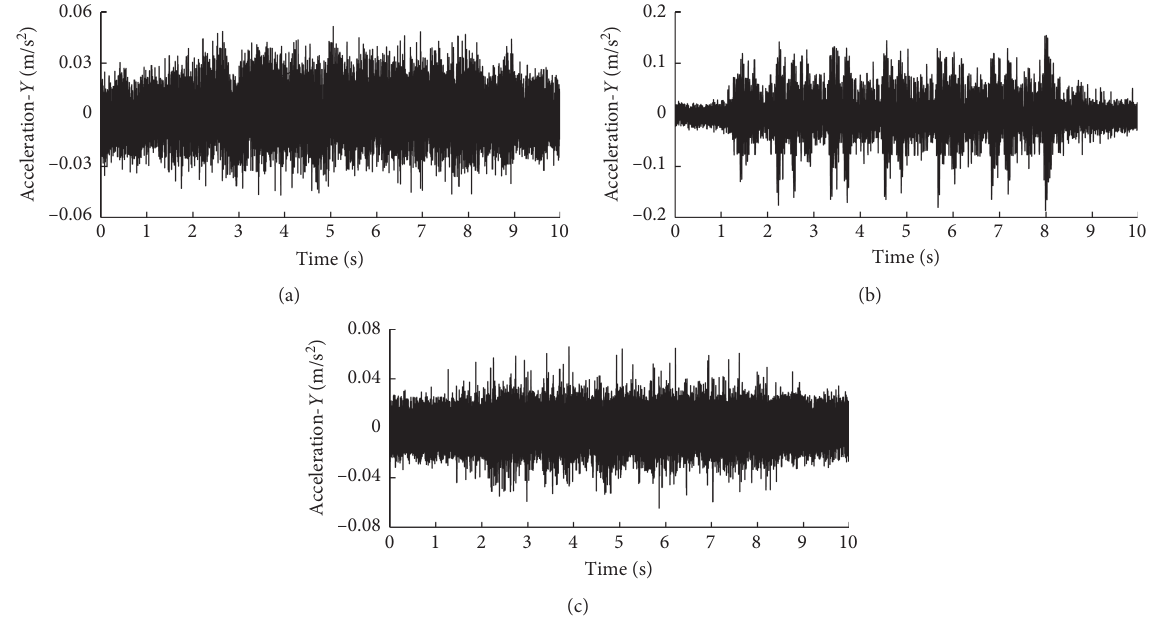
Figure 13: Time history curves of transversal accelerations: (a) A021; (b) A024; (c)